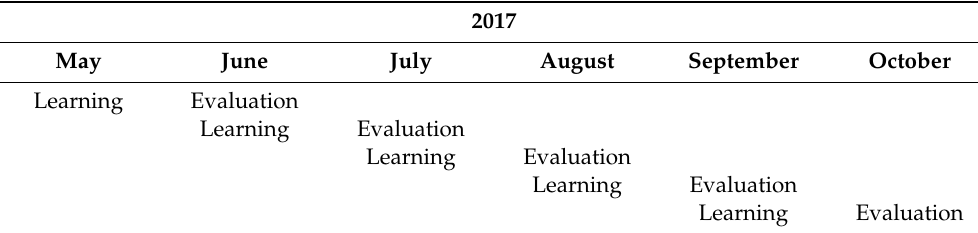
Table 8. Relationship between learning period and evaluation period.